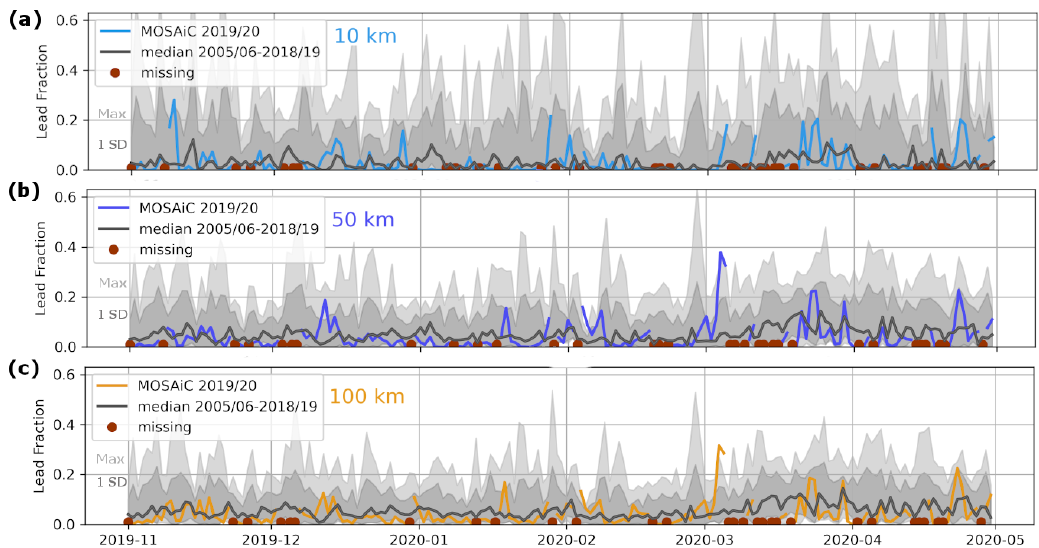
Figure 16. Temporal evolution of the lead fraction around the CO during MOSAiC for (a) a radius of 10km (light blue), (b) 50km (dark blue) and (c) 100km (orange), respectively. Maximum (light gray area), mean (black line) and 1 standard deviation (dark gray area) of the lead fraction for the reference period 2005–2006 to 2018–2019 are shown for comparison.